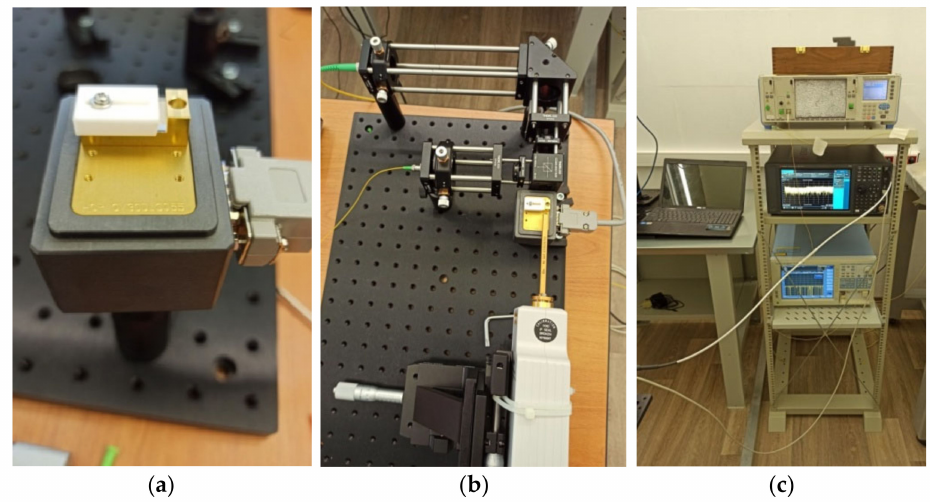
Figure 1. Photos of the fastening system ( a – c ) of a ferroelectric lithium niobate crystal on an experi- mental setup using a specialized heating interface and free-space setup ( b ), designed to increase the efficiency of the crystal (the heating driver is not shown; heater ( a ) is open); ( c ) measurement setup including both optical and radio spectrum analyzers and a light source